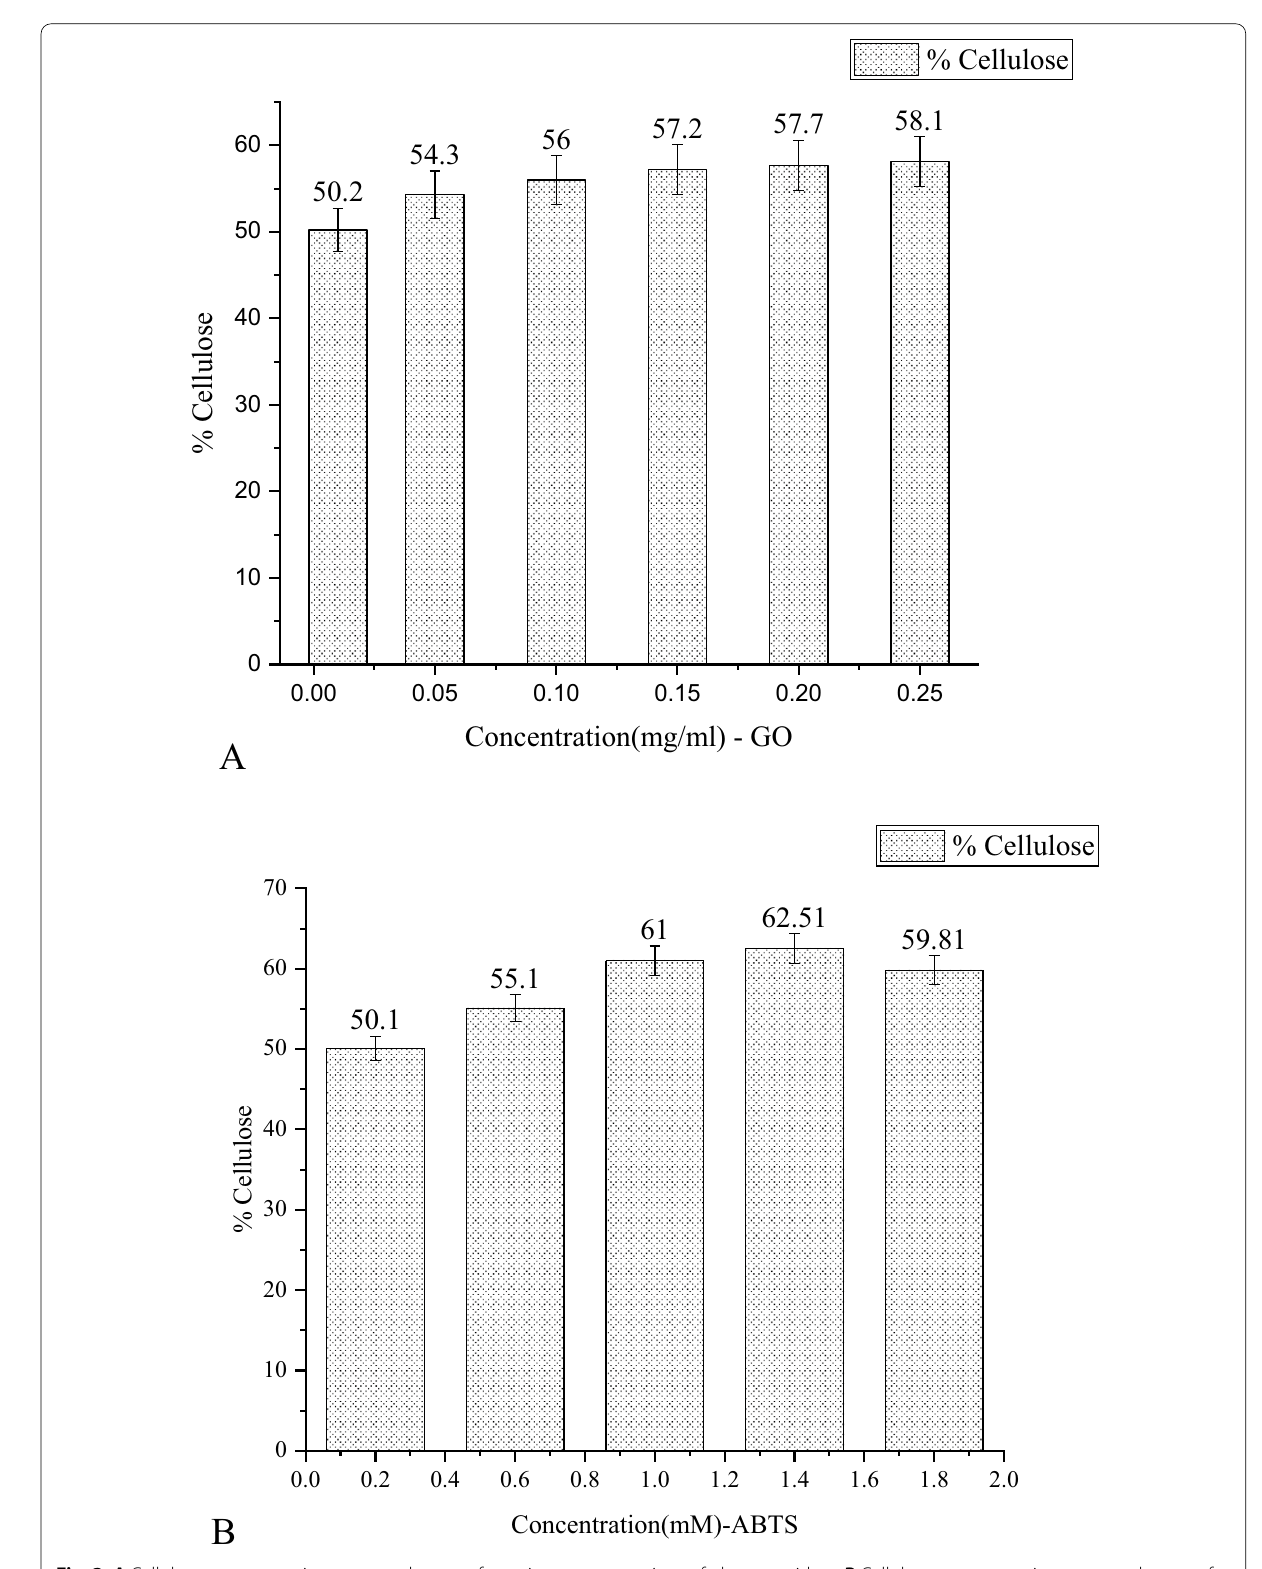
Fig. 3 A Cellulose percentage in sugarcane bagasse for various concentrations of glucose oxidase. B Cellulose percentage in sugarcane bagasse for various concentrations of